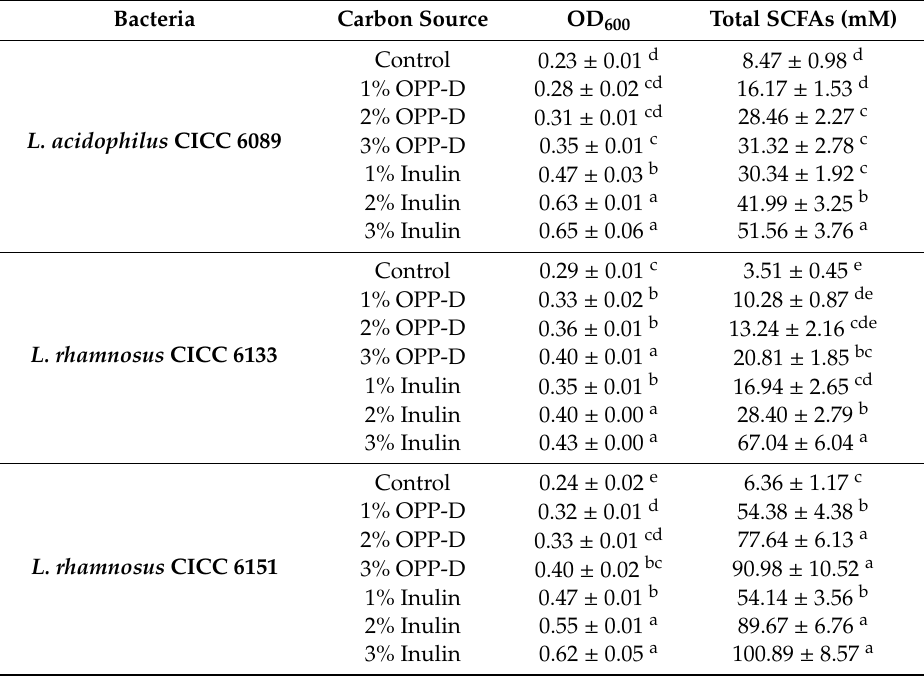
Table 1. E ff ect of OPP-D on the growth and production of short-chain fatty acids of three probiotics after fermentation for 24